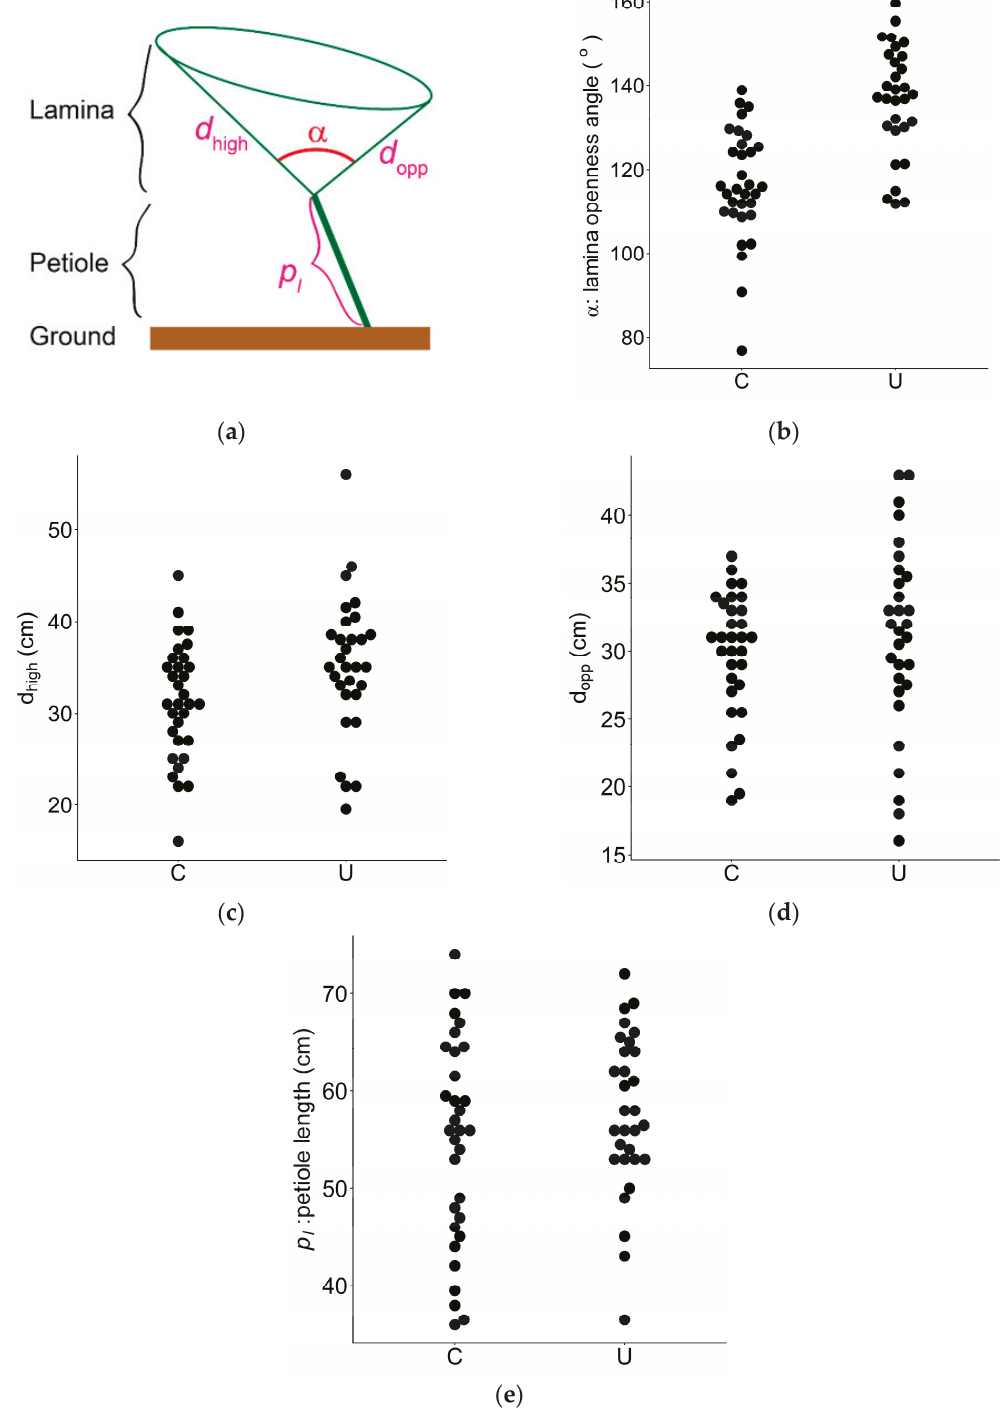
Figure 5. ( a – e ) Leaf shape parameters in the understory (U) and in the clearing (C). Each closed circle indicates one leaf (i.e., bee swarm